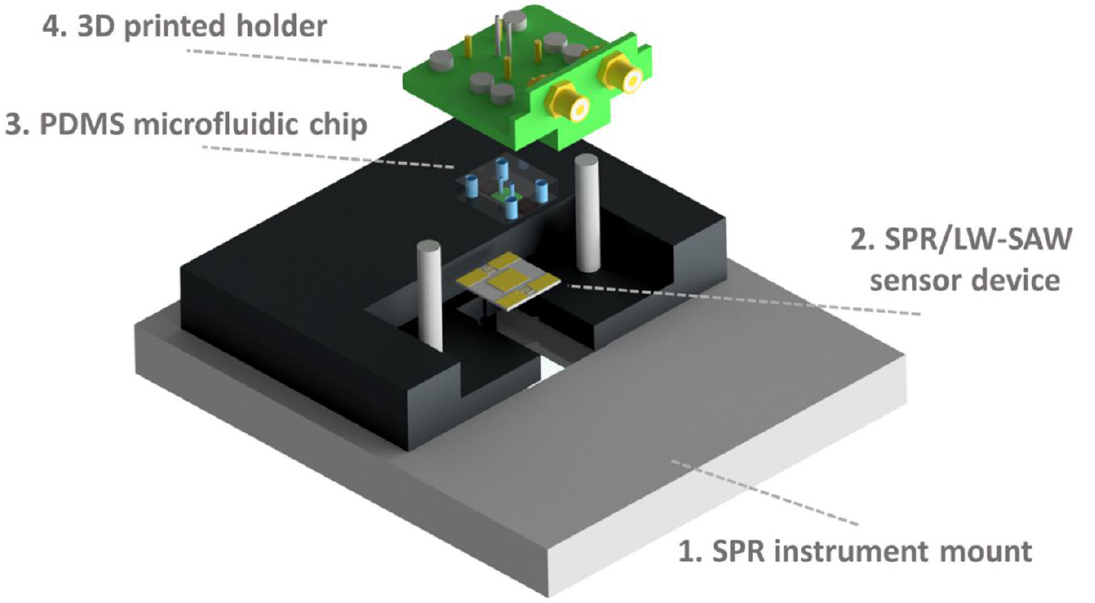
Figure 4. Experimental set-up assembly: First, the SPR/LW-SAW sensor device (2) is placed on the mount of the SPR instrument (1). Then, the PDMS chip (3) is fixed to the 3D-printed holder (4) and applied on the device surface. Reproduced with permission from Samarentsis et al. [31], Sensors, 20, 6177. Published by MDPI, 2020.